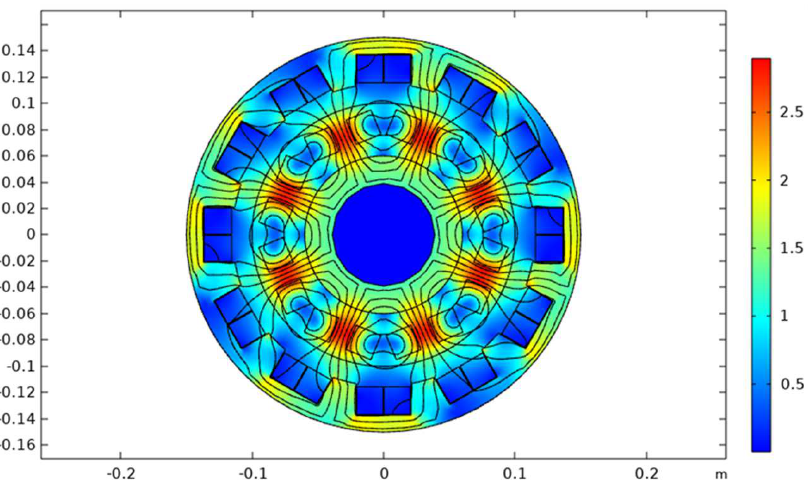
Figure 3. Magnetic flux cloud map showing the distribution of flux density and magnetic induction line.